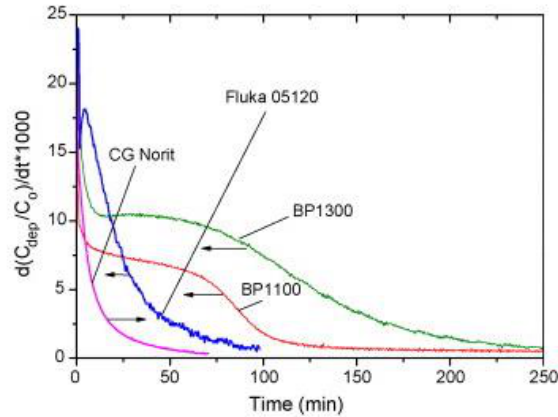
Figure 2. Decline in deposition rate (normalized to initial carbon mass), and variability for different carbon blacks (BP1300, BP1100, Fluka 05120), and an activated carbon (CG Norit) [34].